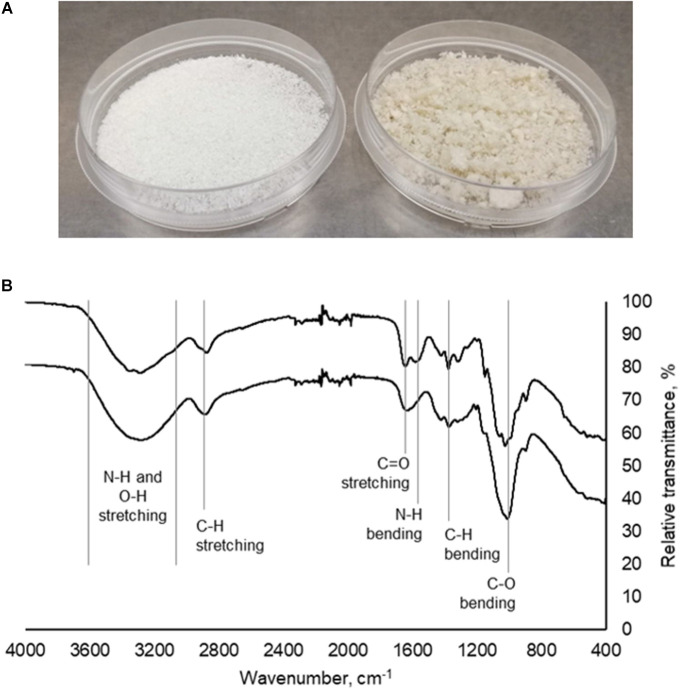
(A) Commercial chitosan (left) and crude mushroom chitosan (right). (B) Infrared spectra of commercial chitosan (top) and mushroom chitosan (bottom).